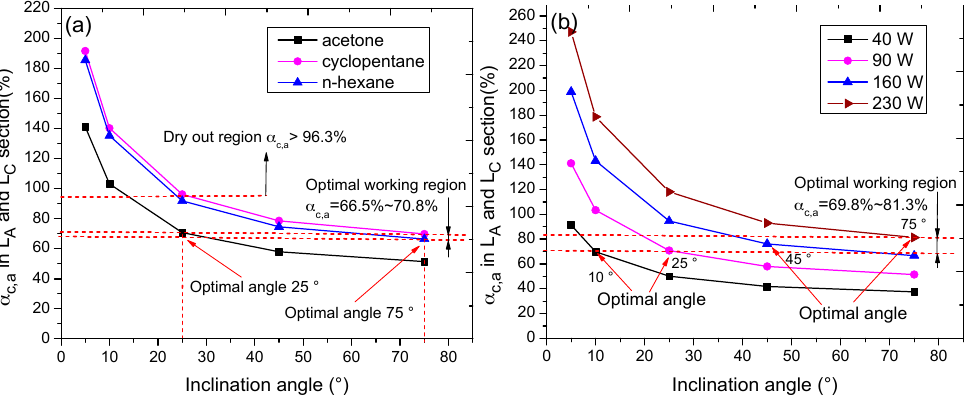
Figure 12. The volumetric fraction α c,a in condensation and adiabatic wick as a function of inclination angle for ( a ) different working fluids at the heat load of 90 W; and ( b ) different heat loads of the acetone MF-AHPA.